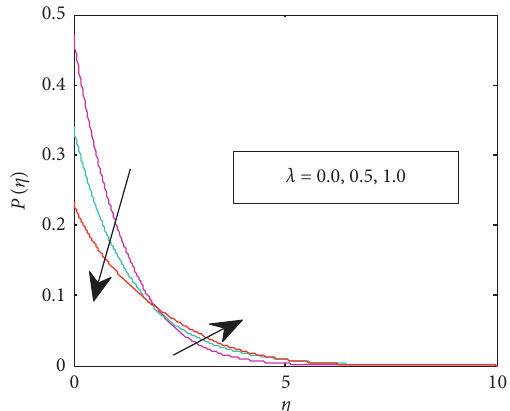
Figure 12: Velocity distribution for different values of couple stress parameters.